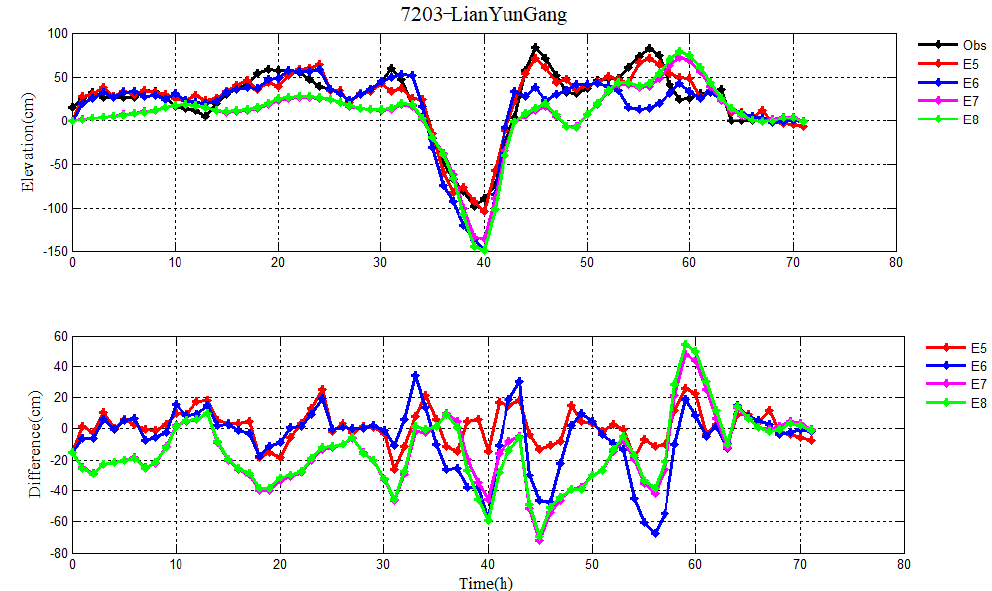
Figure 11. Pure storm surge levels without the astronomical tides in E5 − E8, observation (black line) ( top ), and their differences ( bottom ) during Typhoon 7203 at LianYunGang station.